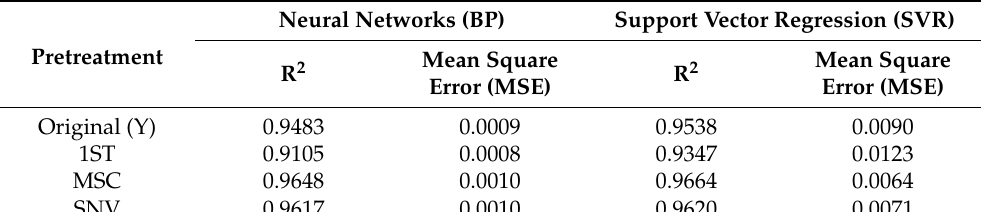
Table 3. Modeling results based on the characteristic band.